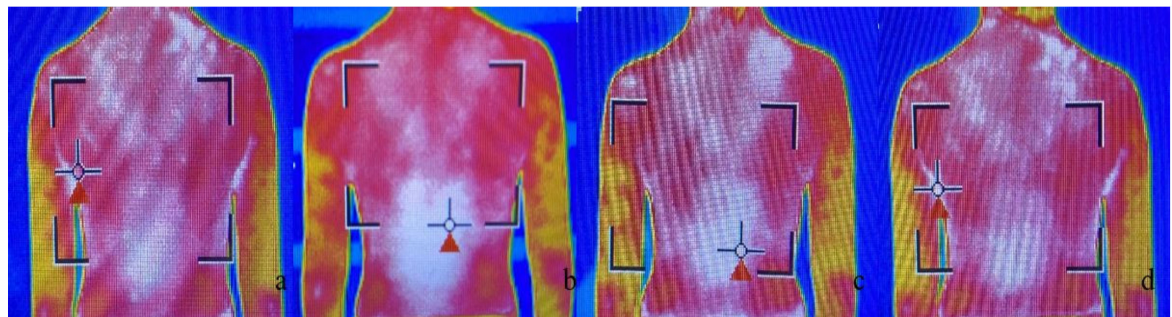
Figure 2. Subject 1 without scoliosis ( a ) image taken at the beginning; ( b ) image taken at the end of exercise 1; ( c ) image taken at the end of exercise 2; ( d ) image taken at the end of exercise 3.